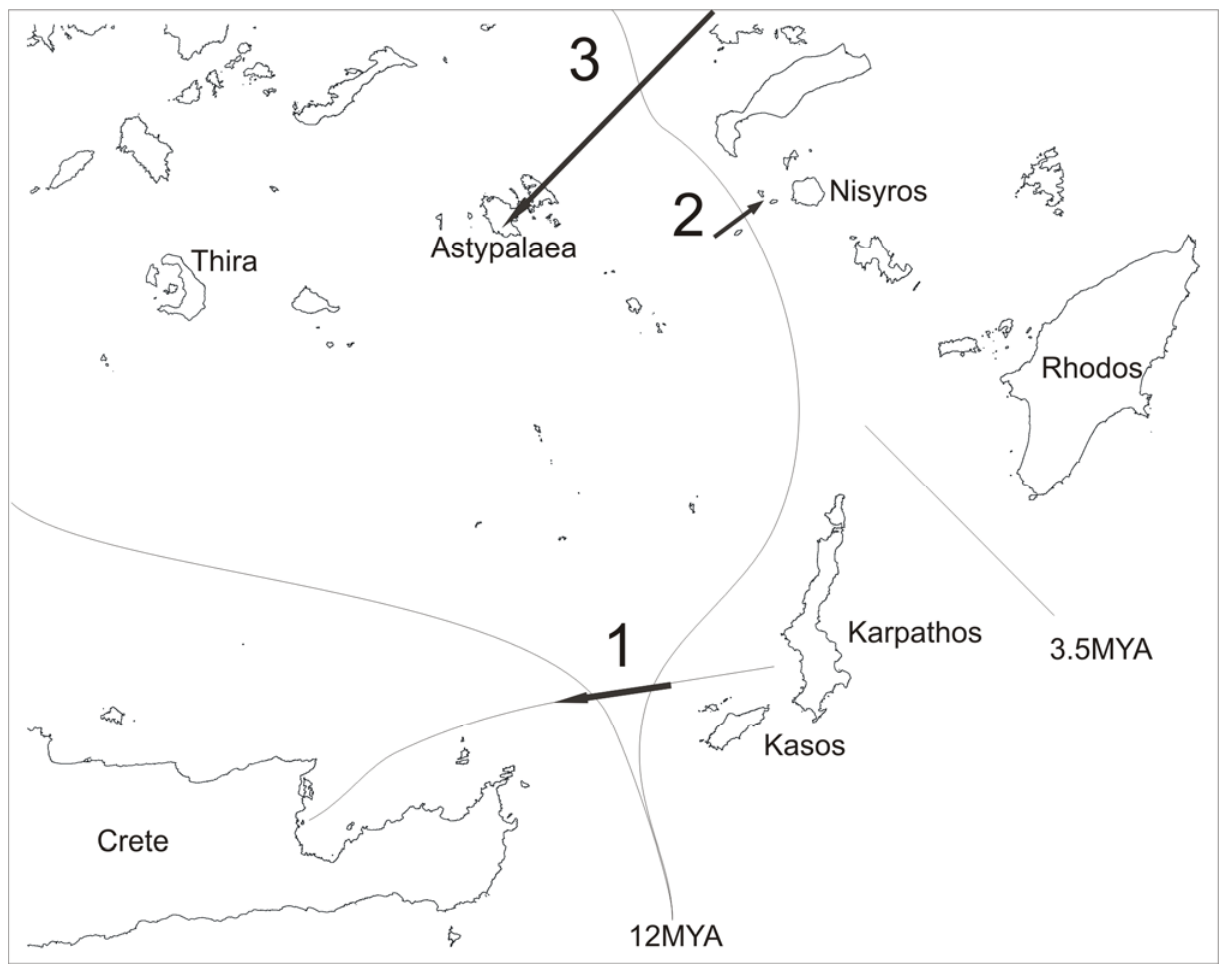
Figure 11. Three cases of documented MAT crossings. 1. Ablepharus crossed from the Kasos − Karpathos complex to a tiny (4.4 ha) islet in the bay of Ag. Nikolaos, Crete. Although an explanation involving rafting appears to be most probable, it is strange how the rafts “missed” Crete or other larger islets. It is equally difficult to explain how another islet in the same bay with an area of 35 ha, less than 50m from the first, , has not been invaded. 2. Podarcis erhardii crossed the MAT towards a couple of volcanic islets west of Nisyros, most probably from an equally small nearby islet west of the trench. 3. One of the few remaining small wetlands in the Cyclades is located on the south part of Astypalaea. It is inhabited by a population of Pelophylax bedriagae with phylogenetic affiliation to populations found in the northern Aegean and northern Turkey [21] and not as one intuitively would have thought from nearby central-western Turkey or